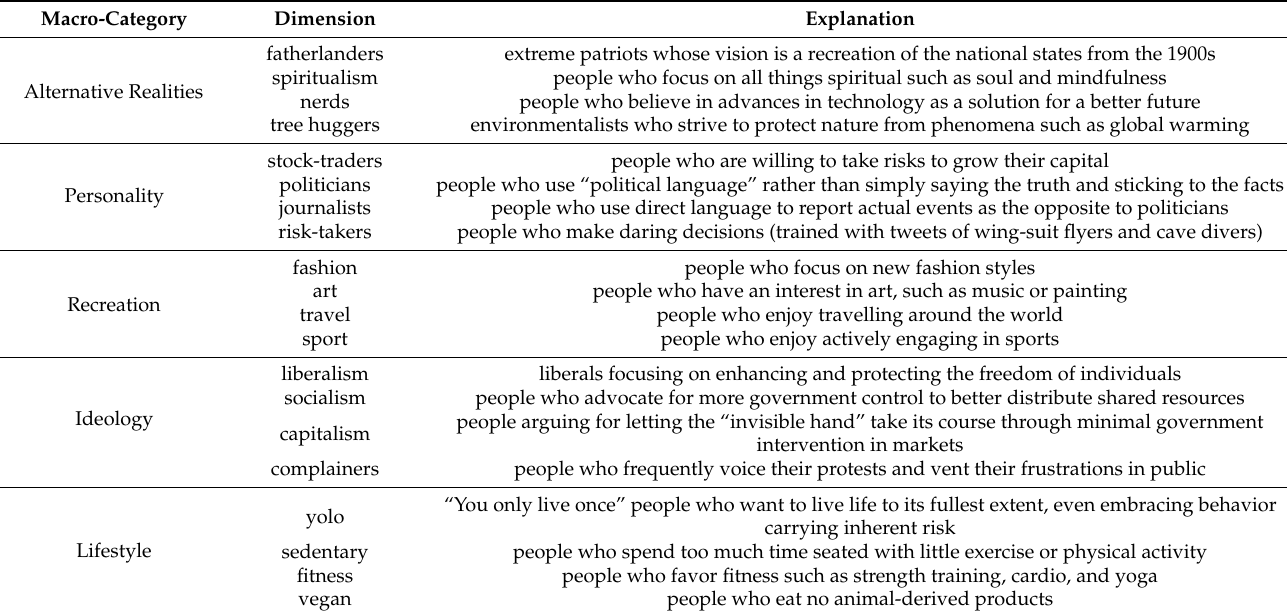
Table 1. Explanation of five macro-categories of tribe used in this paper, each of them includes four dimensions.